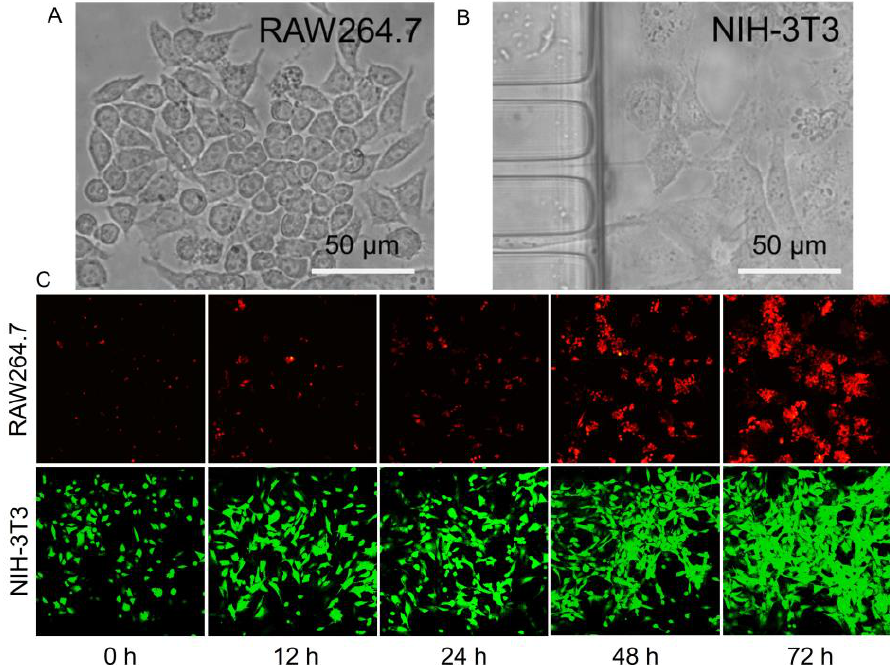
Figure 3. ( A ) and ( B ) Microscope images of macrophages and fibroblasts in white light and the morphology of RAW264.7 and NIH-3T3 cells cultured in the microfluidic chip. ( C ) Fluorescence images of macrophages and fibroblasts with increased incubation time.